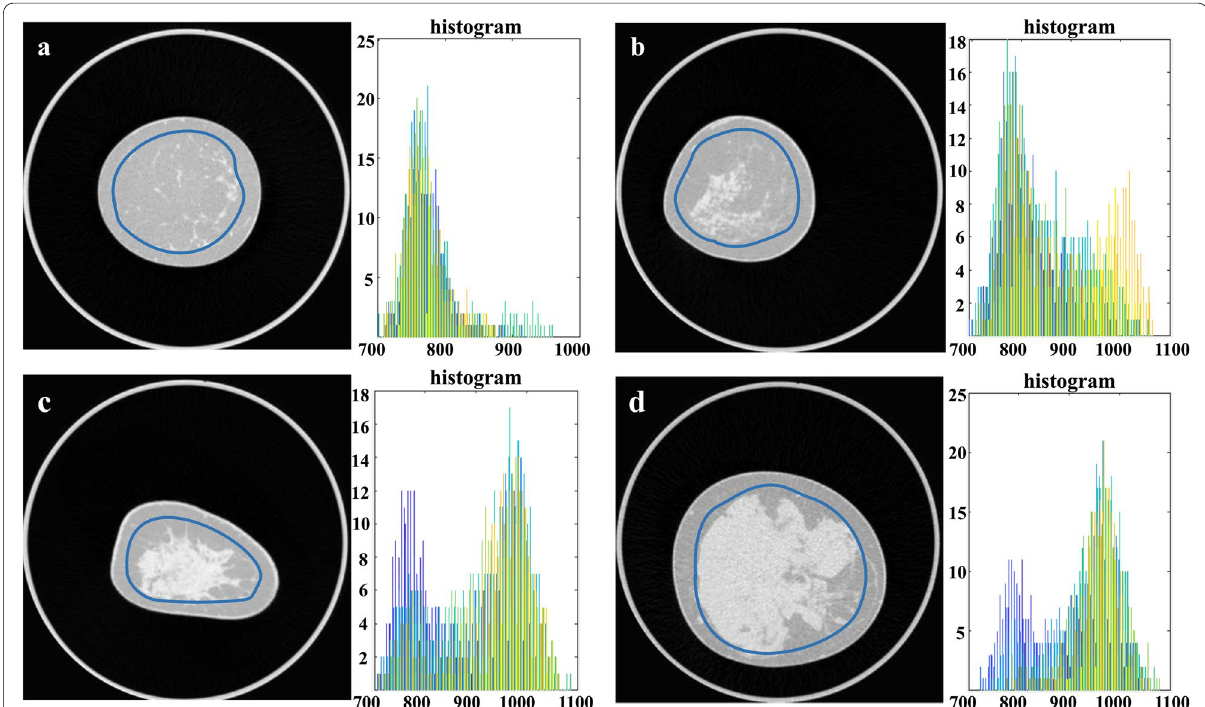
Fig. 2 Example definitions of regions of interest for each breast density level ( a , b , c , or d ) and corresponding histogram graphs summarised for all 50 automatically evaluated images. Histograms depict the number of pixels found at each pixel value; whereas the left side on the x -axis represents lower signal values, the right side on the x -axis represents higher signal values. In the histograms, two peaks can be distinguished corresponding to fatty and glandular tissue, respectively. The ratio between the two peaks depends on the breast density, with class a mostly showing the peak corresponding to fatty tissue, whereas the histogram graph for class d demonstrating mostly the peak corresponding to glandular